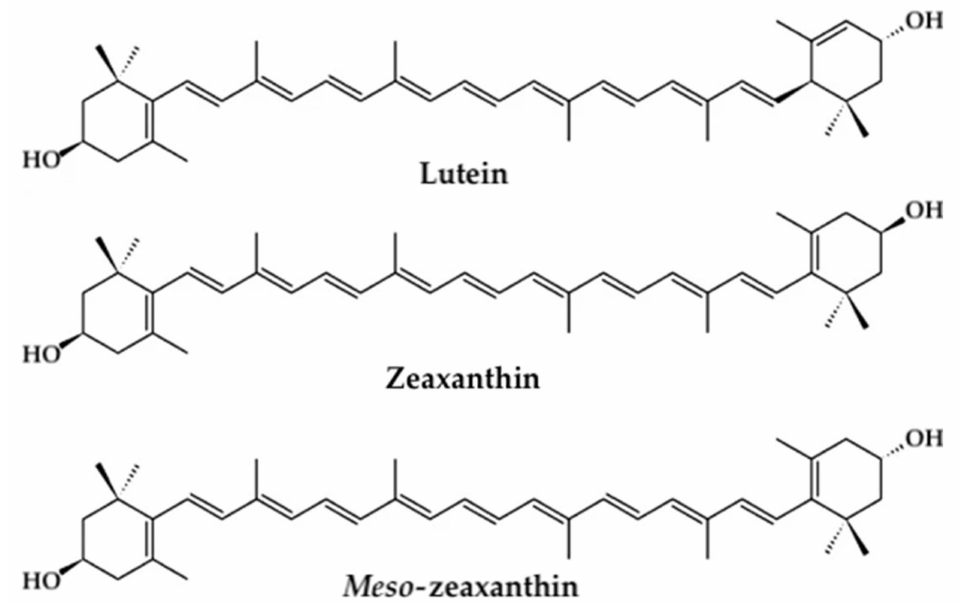
Figure 1. Chemical structures of isomeric xanthophyll carotenoids lutein, zeaxanthin, and meso -zeaxanthin. Retinal Changes in